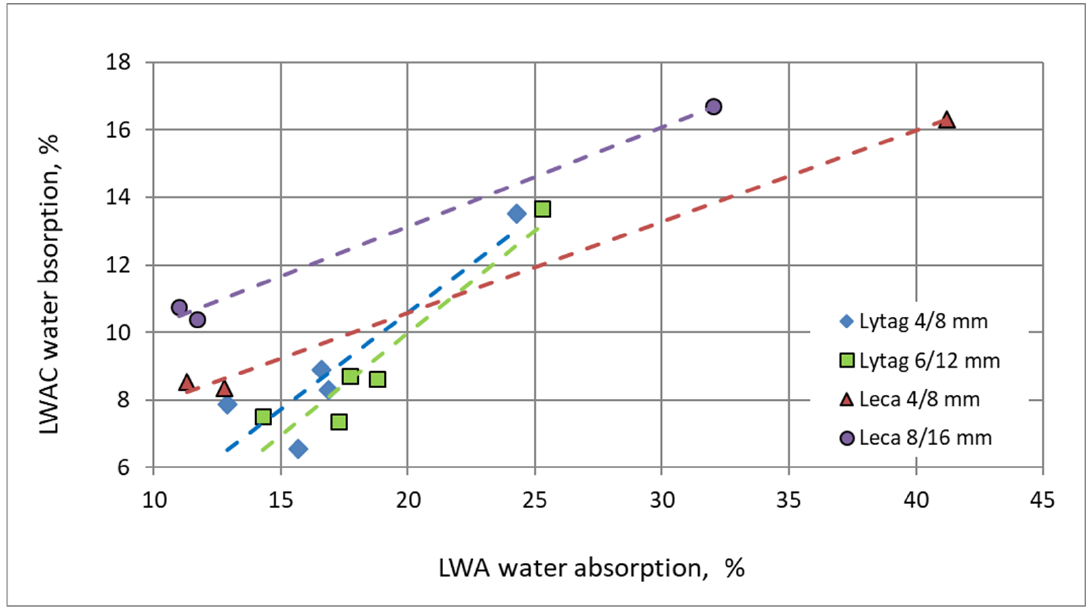
Figure 9. Relationship between mean water absorption of aggregates and water absorption of com- posites.